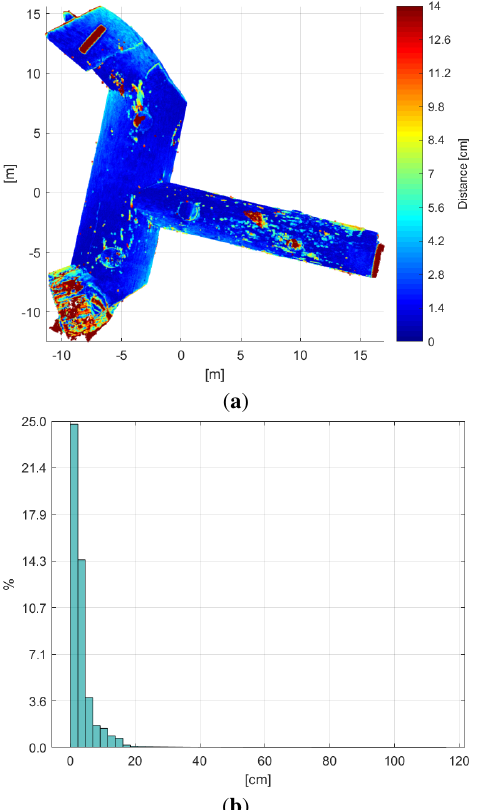
Figure 5. Comparison of UWB anchor positions: surveyed (red dots) and obtained by means of the self-positioning procedure (blue dots). Case studies: ( a ) Impossible bastion, ( b ) Savonarola gate.